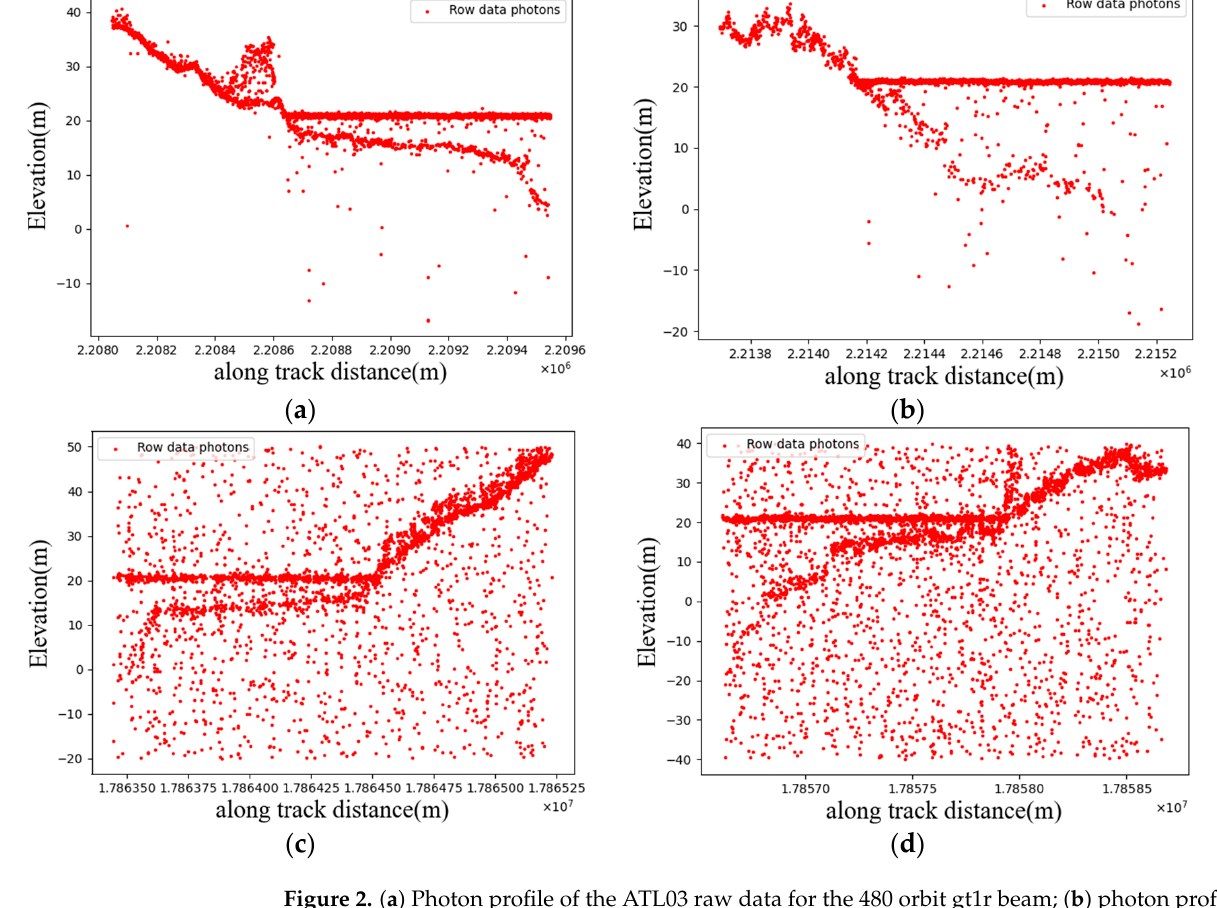
Figure 2. ( a ) Photon pro fi le of the ATL03 raw data for the 480 orbit gt1r beam; ( b ) photon pro fi le of the ATL03 raw data for the 480 orbit gt2r beam; ( c ) photon pro fi le of the ATL03 raw data for the 1036 orbit gt2r beam; ( d ) photon pro fi le of the ATL03 raw data for the 1036 orbit gt1r beam.